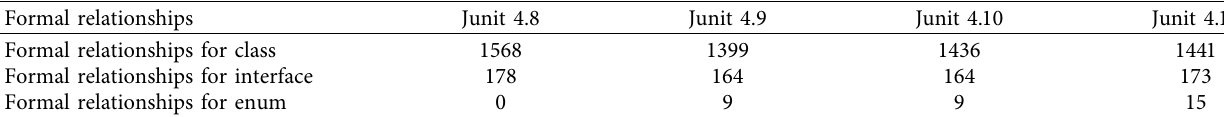
Table 17: Formal relationships in Junit.